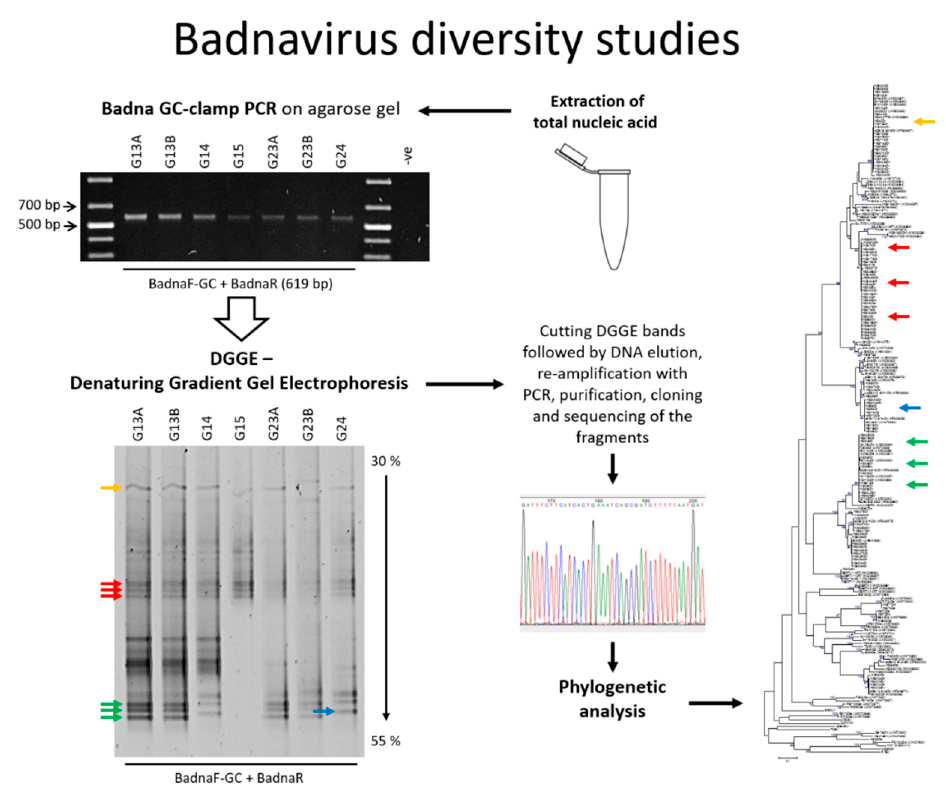
Figure 1. Graphical workflow describing badnavirus diversity studies using denaturing gradient gel electrophoresis (DGGE). PCR: polymerase chain reaction.